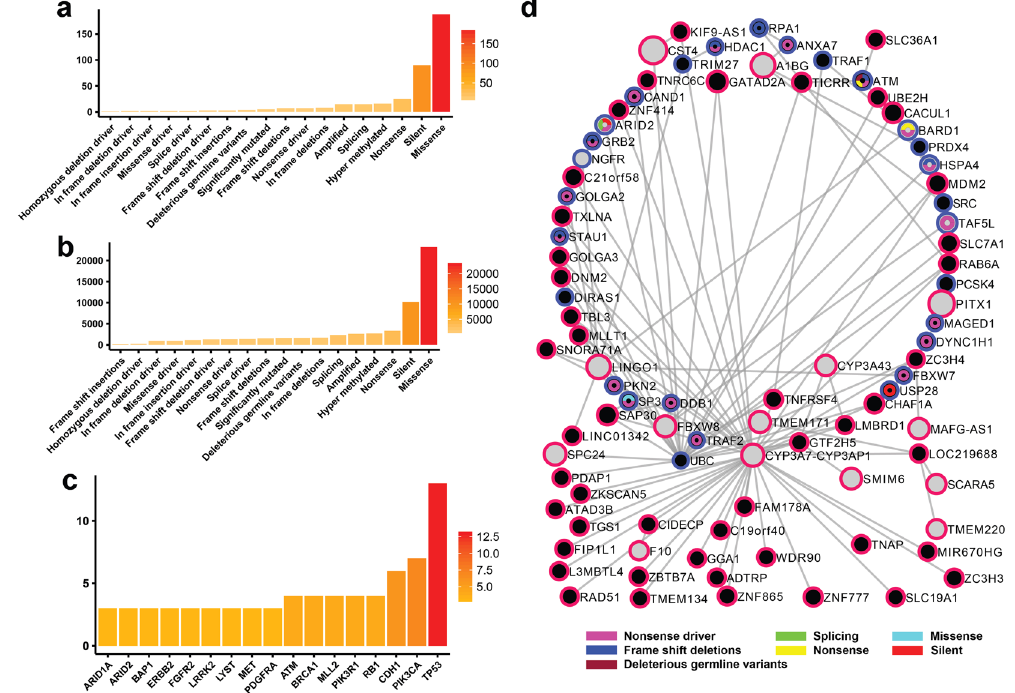
Figure 5. Reconstructed genetic landscape of breast cancer PIE-MIN. The reconstructed breast cancer PIE- MIN illustrates the ( a ) frequency of a given mutation type; ( b ) cumulative number of protein interacting partners by mutation type; ( c ) frequency of mapped genes showing at least three different mutation types; ( d ) Presence of cancer-related Class I and Class II genes.